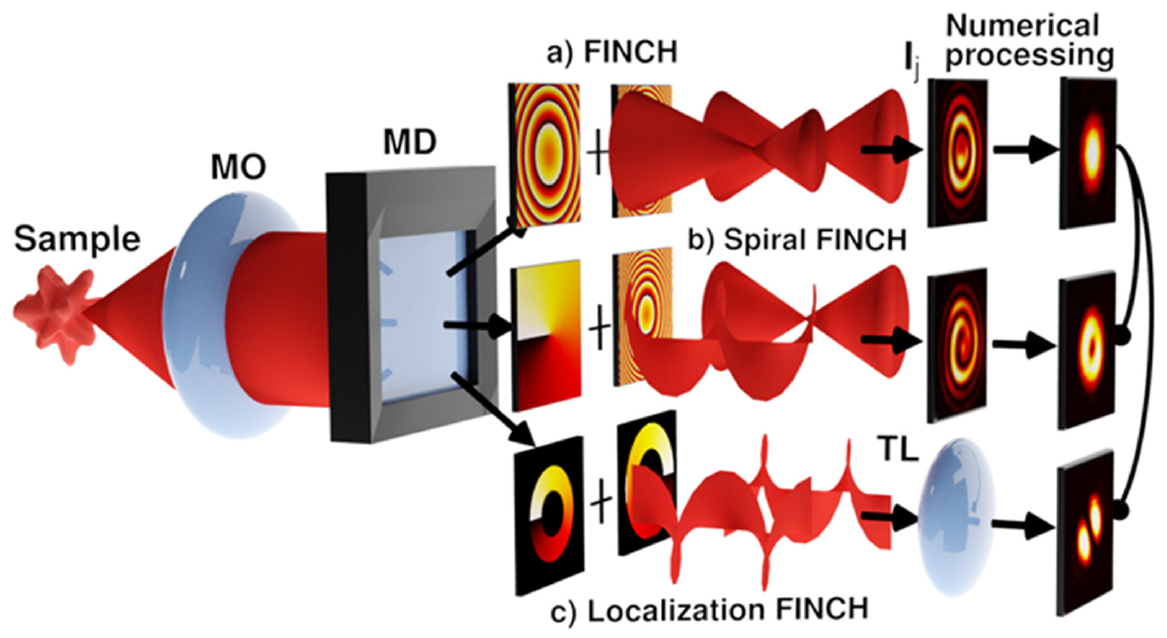
Figure 15. Illustration of vortex FINCH and spatial light shaping in ( a ) standard, ( b ) spiral, and ( c ) localization FINCH imaging. MO—microscope objective; MD—modulation device; TL—tube lens.